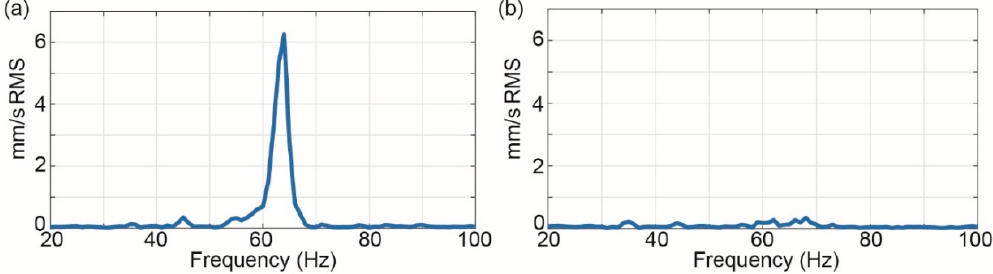
Figure 8. Vibration spectra with ( a ) continuous spindle speed variation (CSSV) off and ( b ) CSSV on at amplitude = 5%, frequency = 0.5 Hz, on a 36” wheelset machining.